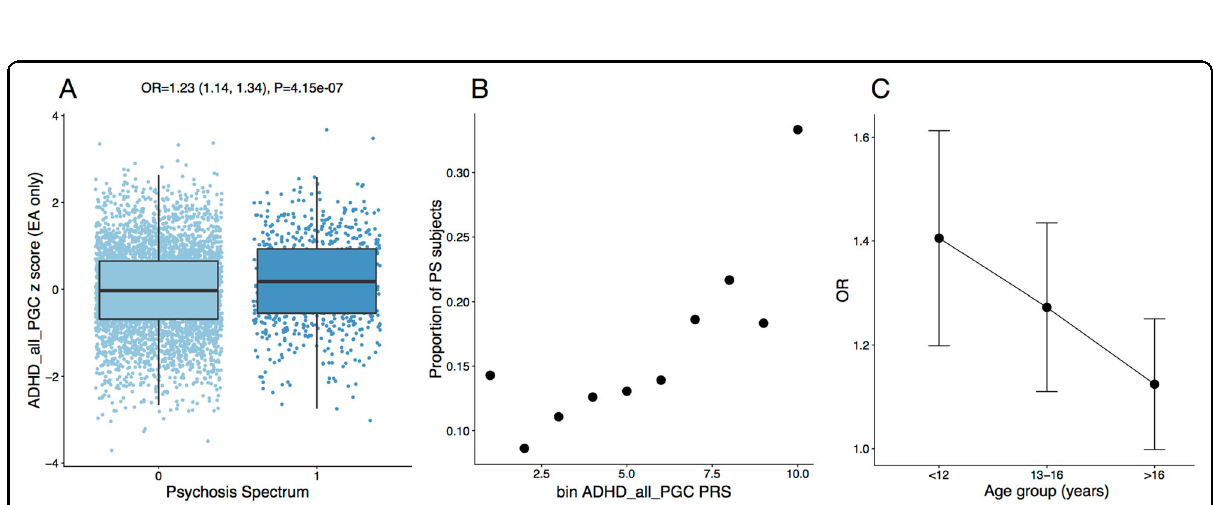
Fig. 3 Univariate regression of ADHD PGS with PS in EA. A Standardized ADHD PGS are higher in EA youth with PS versus non-PS youth. Each SD increase in PGS is associated with an OR = 1.23 CI = (1.14, 1.34), P = 4.15e-07. B Proportion of cases with PS per PGS decile. C Relative association in different age-bins (8 – 12, 12 – 16, and 16 – 22). The association between ADHD PGS and PS is strongest in youngest children 12 and younger. Adding the interaction term of age:PGS to the full model is signi fi cant ( P =